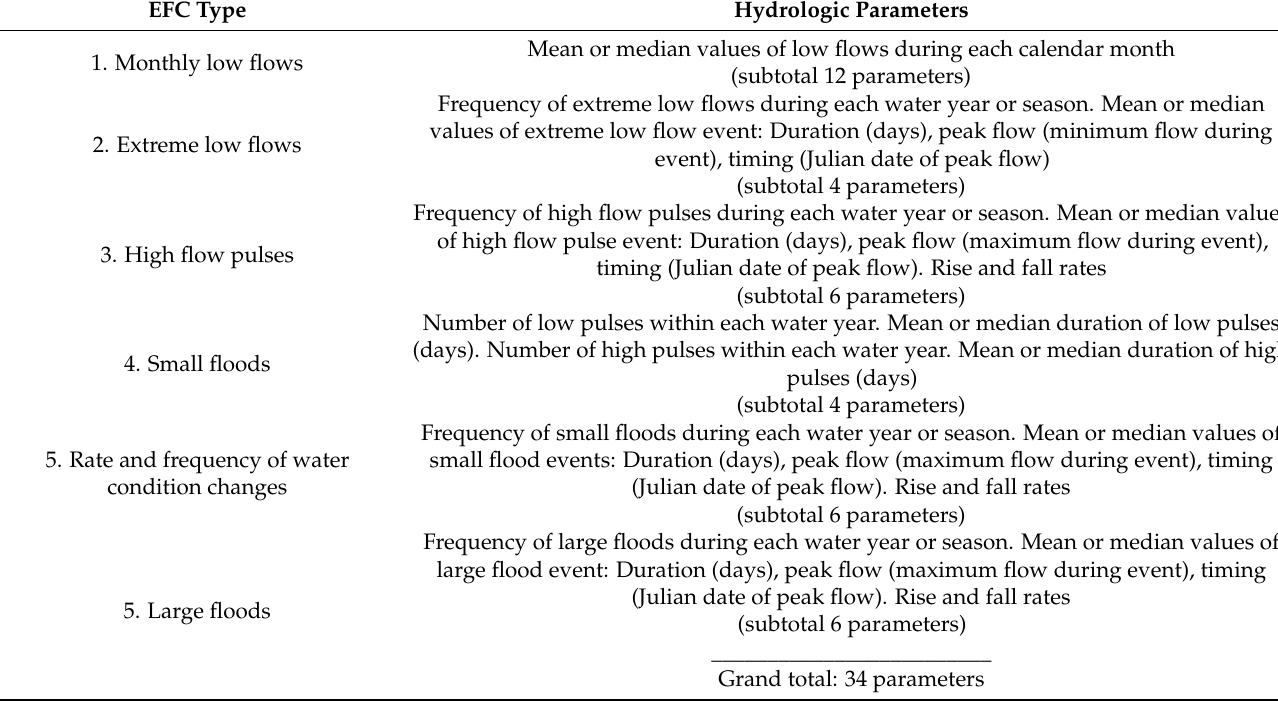
Table A2. Summary of Environmental Flow Component